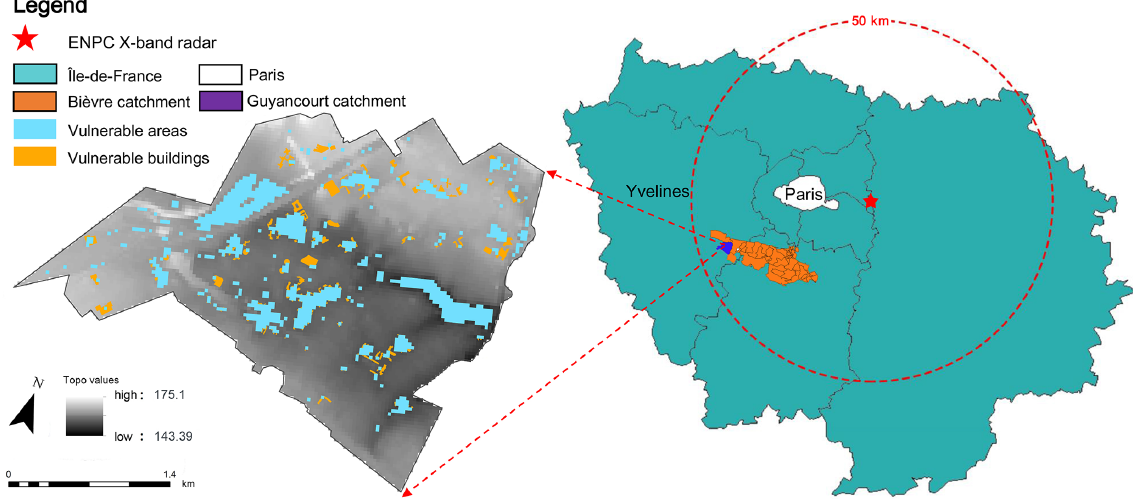
Figure 1. Location of the study site and the corresponding topography map, highlighting some vulnerable areas and buildings at risk of waterlogging in the Guyancourt catchment.